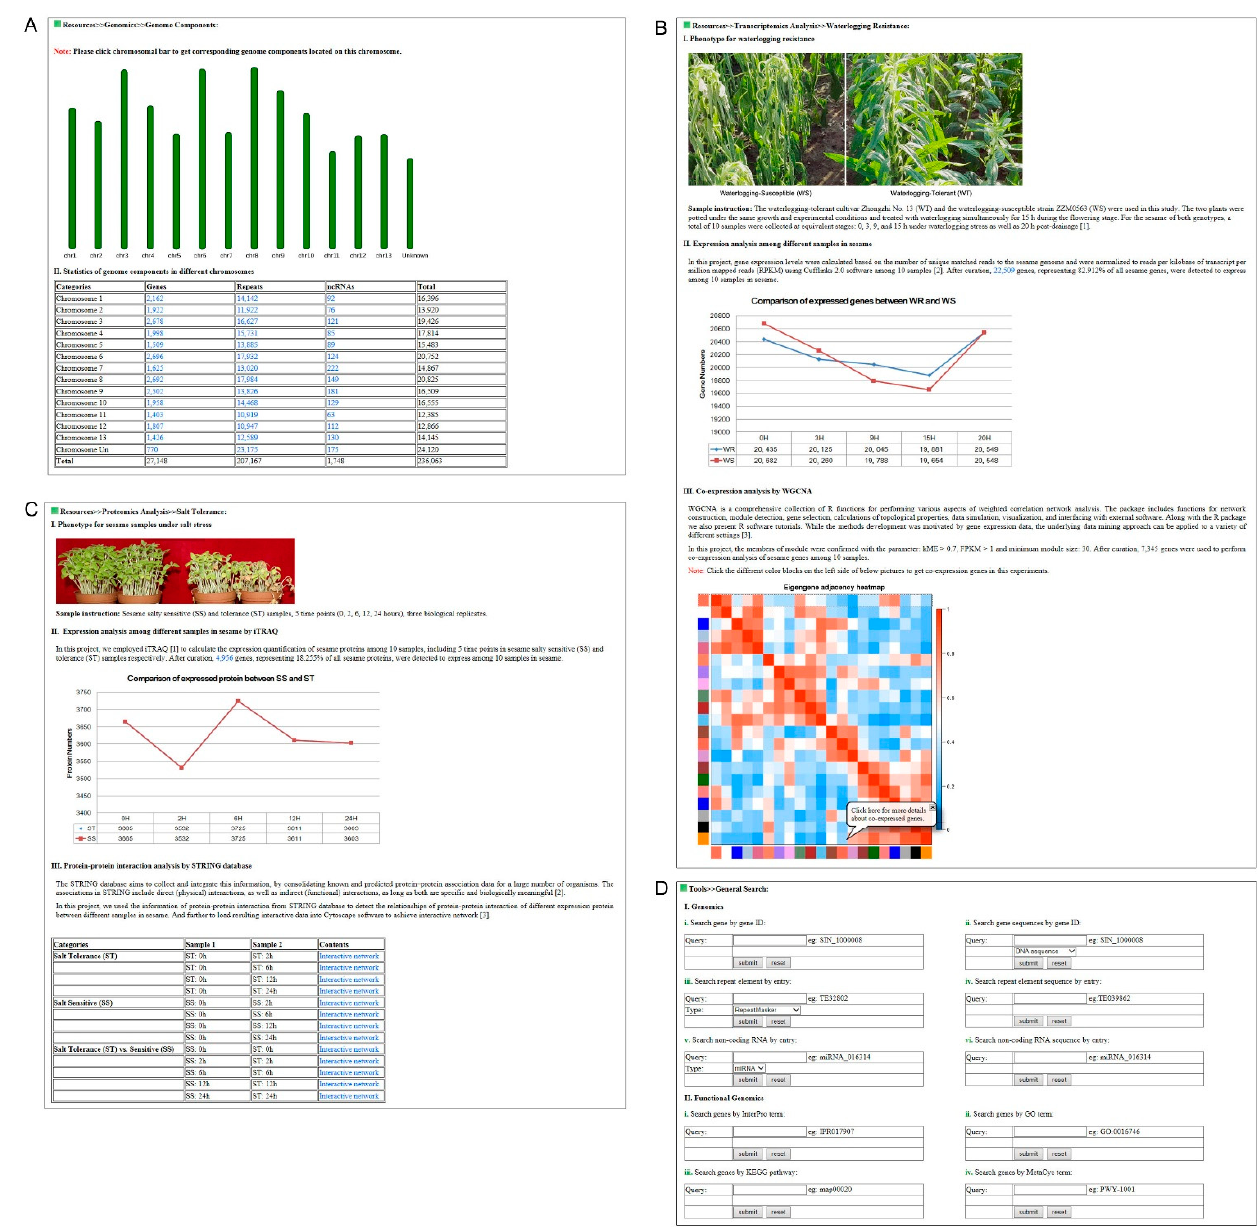
Figure 2. Screenshots of main functional pages in Sinbase 2.0. ( A ) Sesame genome components including protein-coding genes, repeat elements and non-coding RNAs. ( B ) Sesame transcriptomics data of waterlogging resistance including phenotype for waterlogging resistance, expression analysis among different samples in sesame and co-expression analysis by WGCNA. ( C ) Sesame proteomics data of salty tolerance including phenotype for sesame samples under salt stress, expression analysis among different samples in sesame by iTRAQ, and protein–protein interaction analysis by STRING database. ( D ) Keyword searching function including genome components and functional identifiers. Table 1. Statistics of genome components of Sesamum indicum genome v2. 0 .